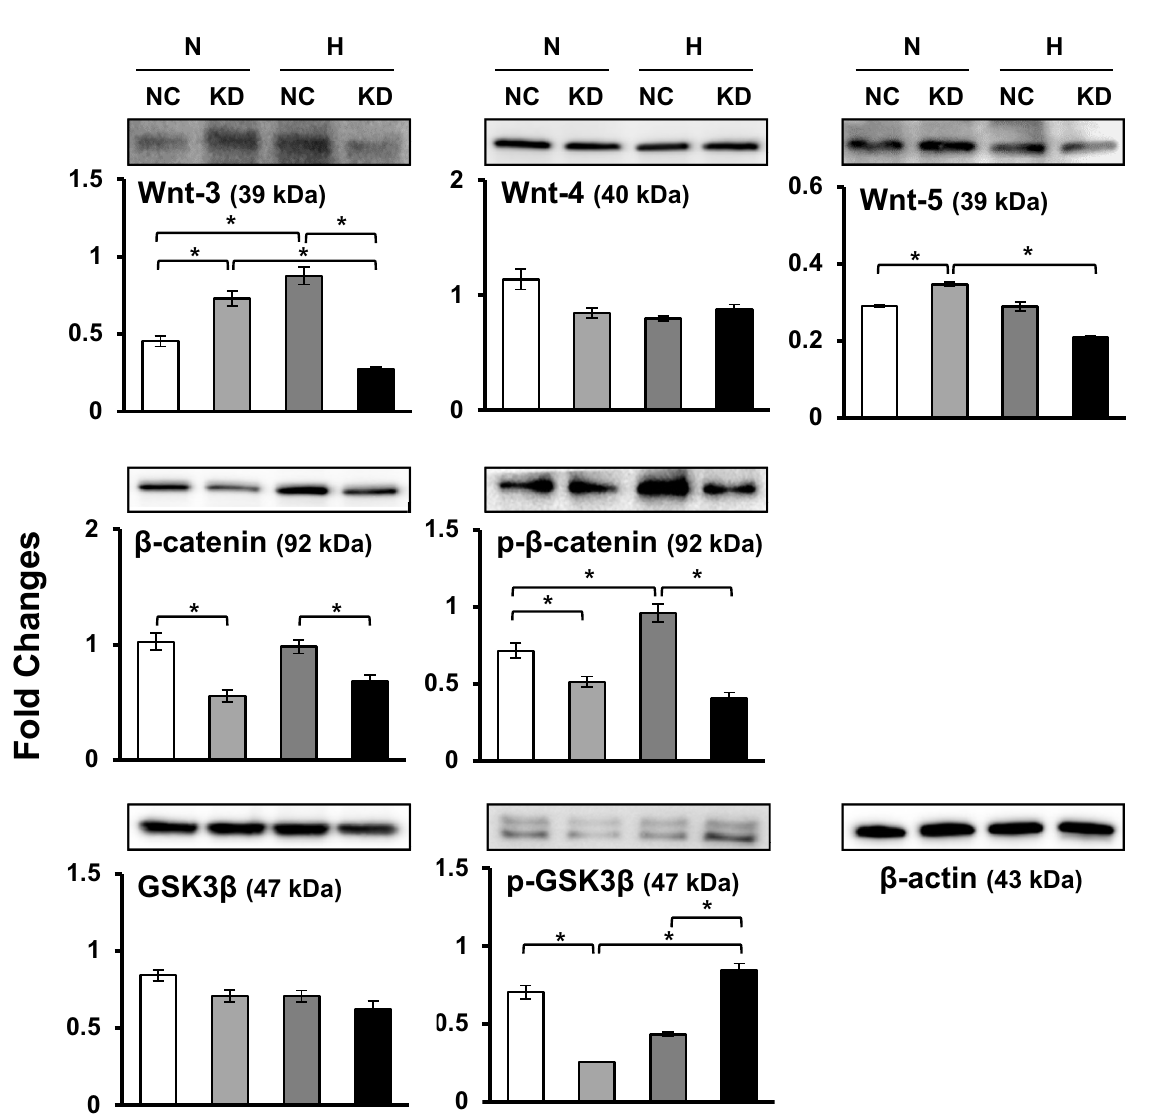
Fig 5. Effects of Sgsm3 knockdown on the Wnt/ β -catenin pathway in rat MSCs. Changes in Wnt/ β -catenin pathway-related protein expression upon Sgsm3 knockdown in MSCs were measured via immunoblot analysis. Band intensity was measured as the area density and analyzed in ImageJ and relative intensity levels indicate protein levels normalized to the β -actin levels. The data are representative of two independent experiments. Significant differences between groups were determined via ANOVA, with p values indicated as � p < 0.05 and �� p < 0.01. N, normoxia; H, hypoxia; NC, negative control cells; KD, knockdown